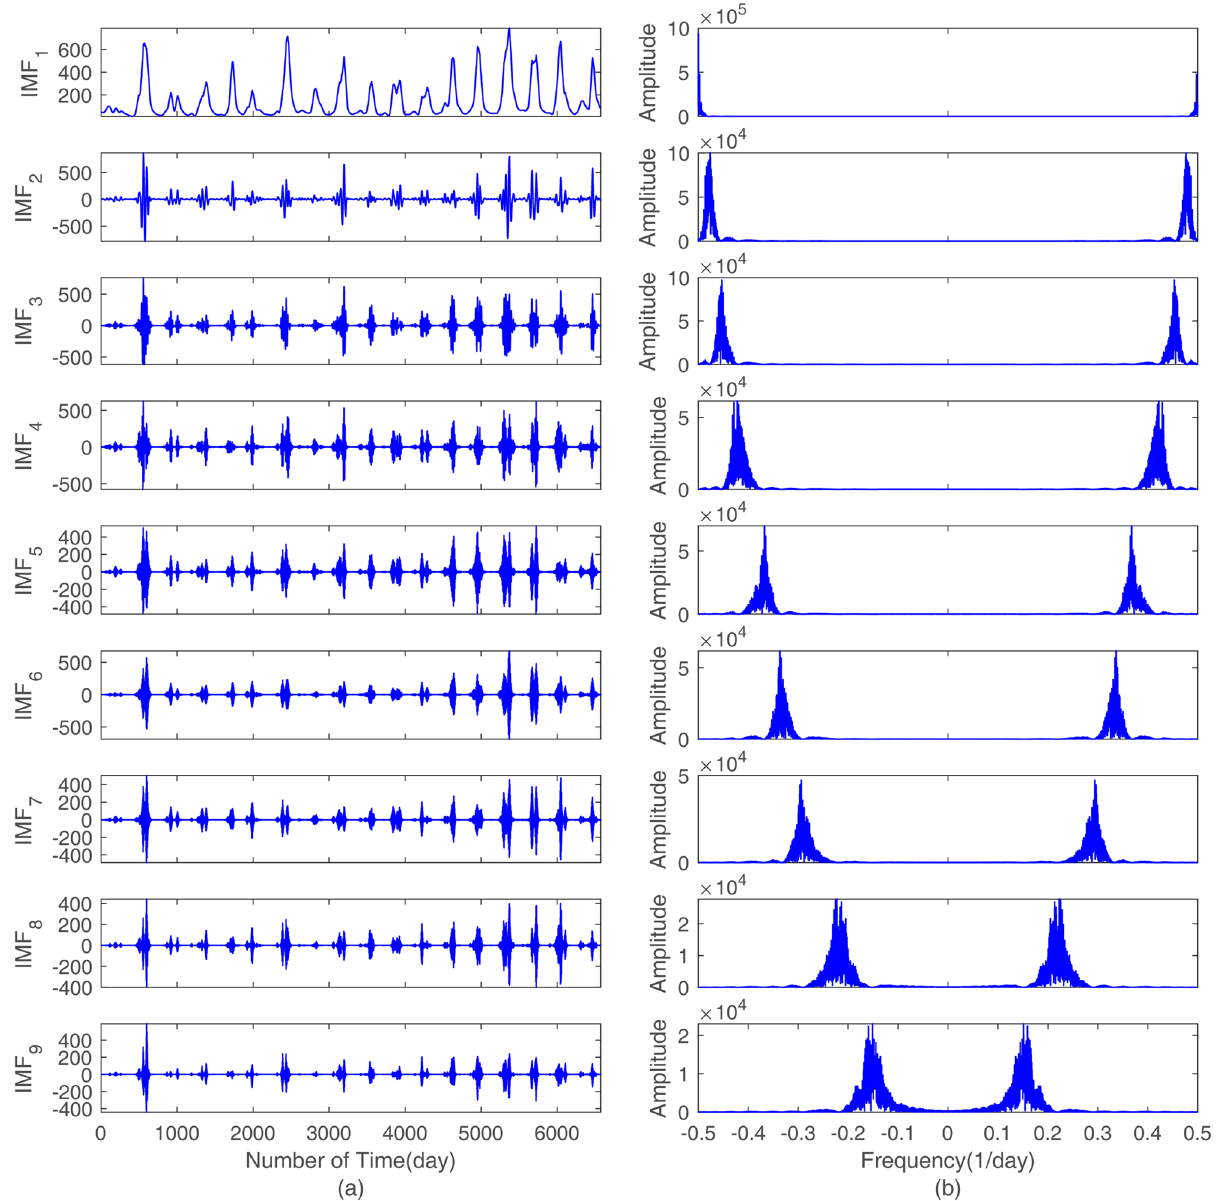
Figure 5. VMD decomposition results: ( a ) the decomposition sequence waveform and ( b ) the frequency spectrum